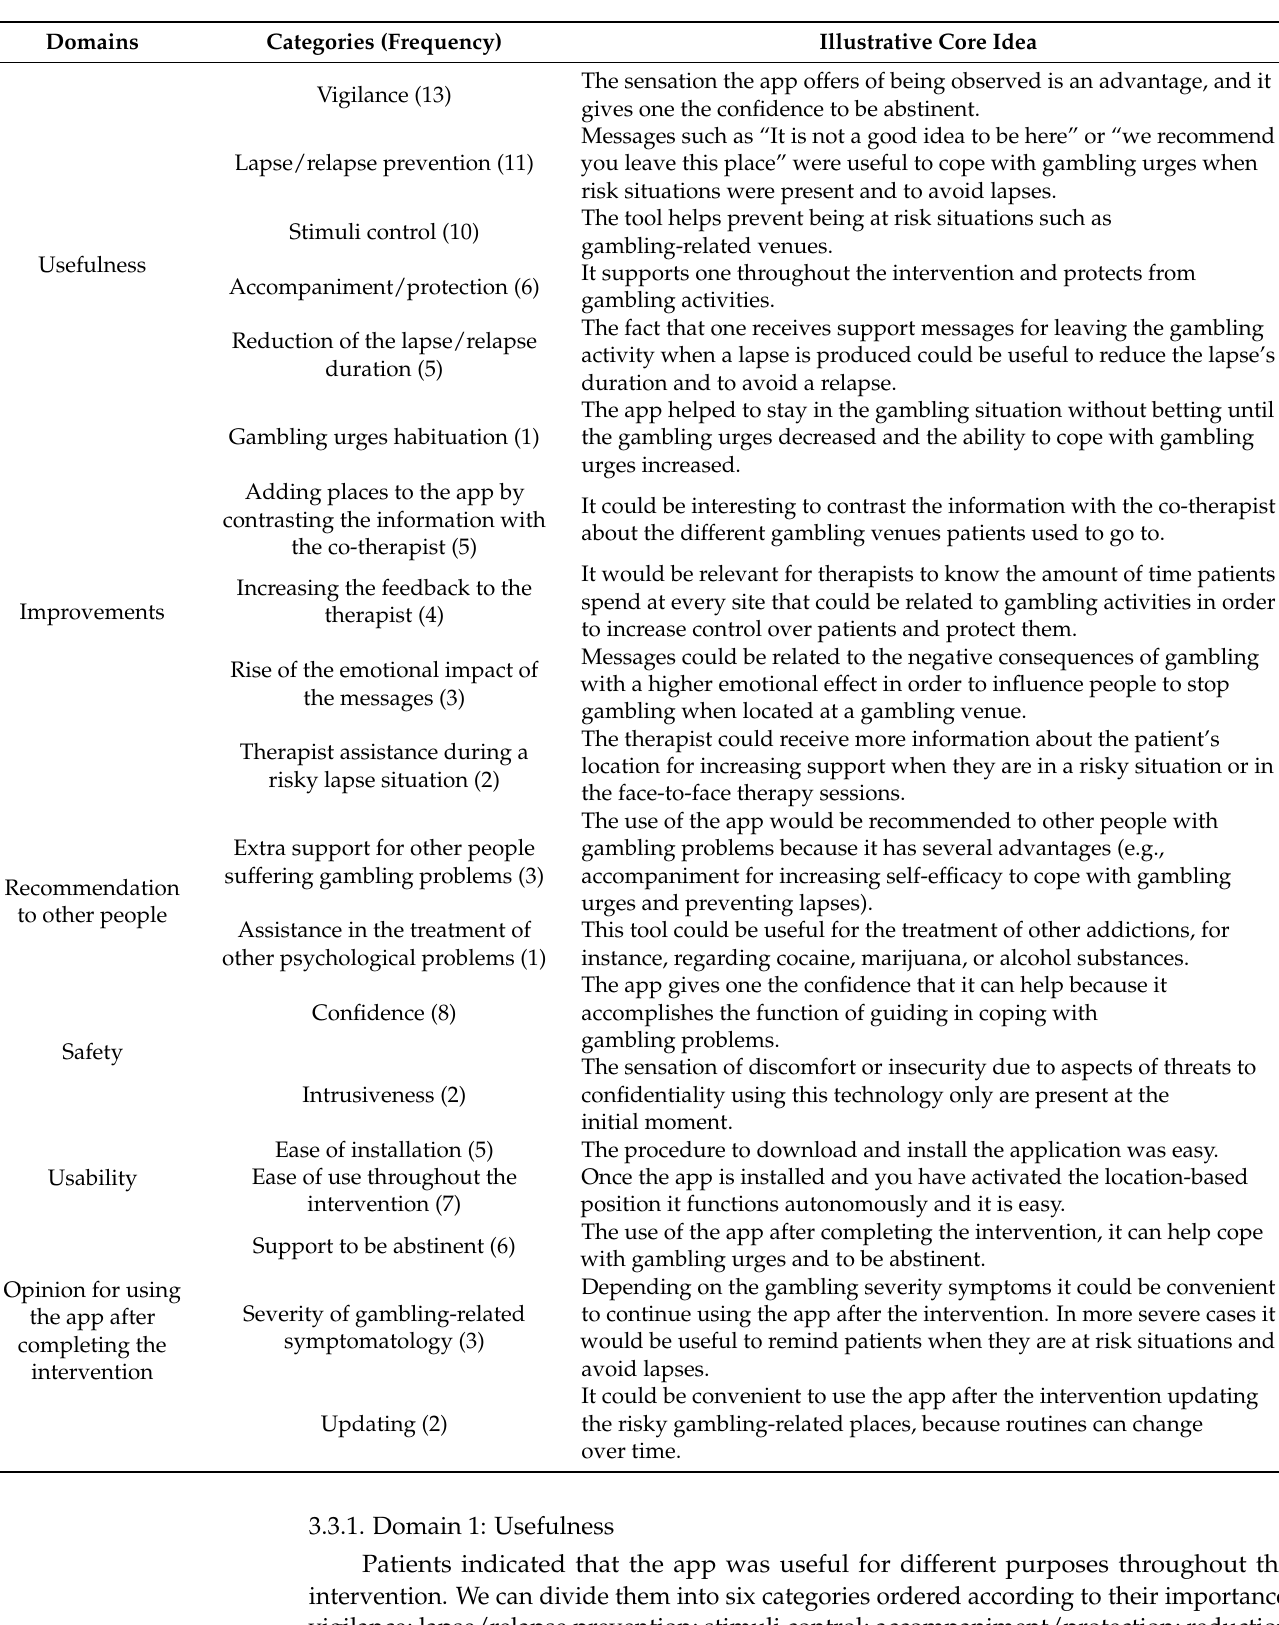
Table 4. Domains, categories, and illustrative